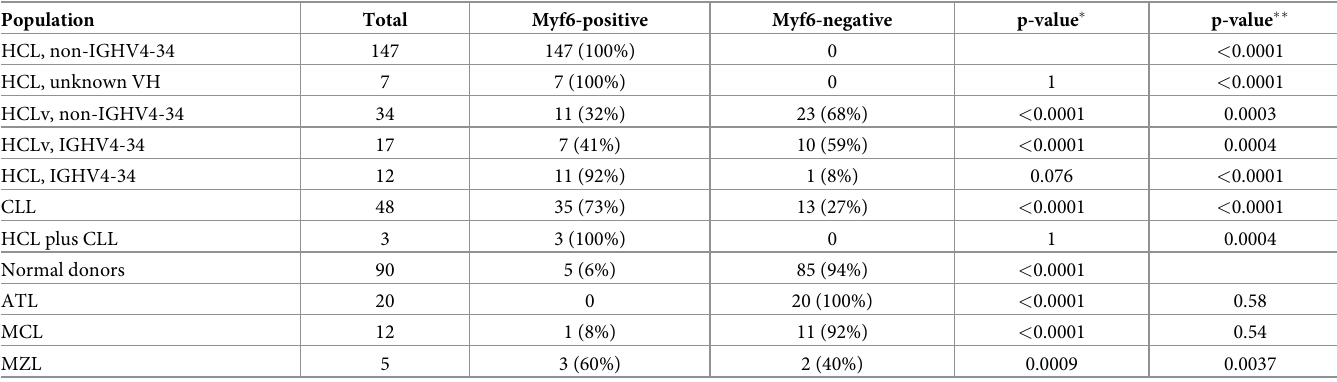
Table 4. Myf6 RQ-PCR results.